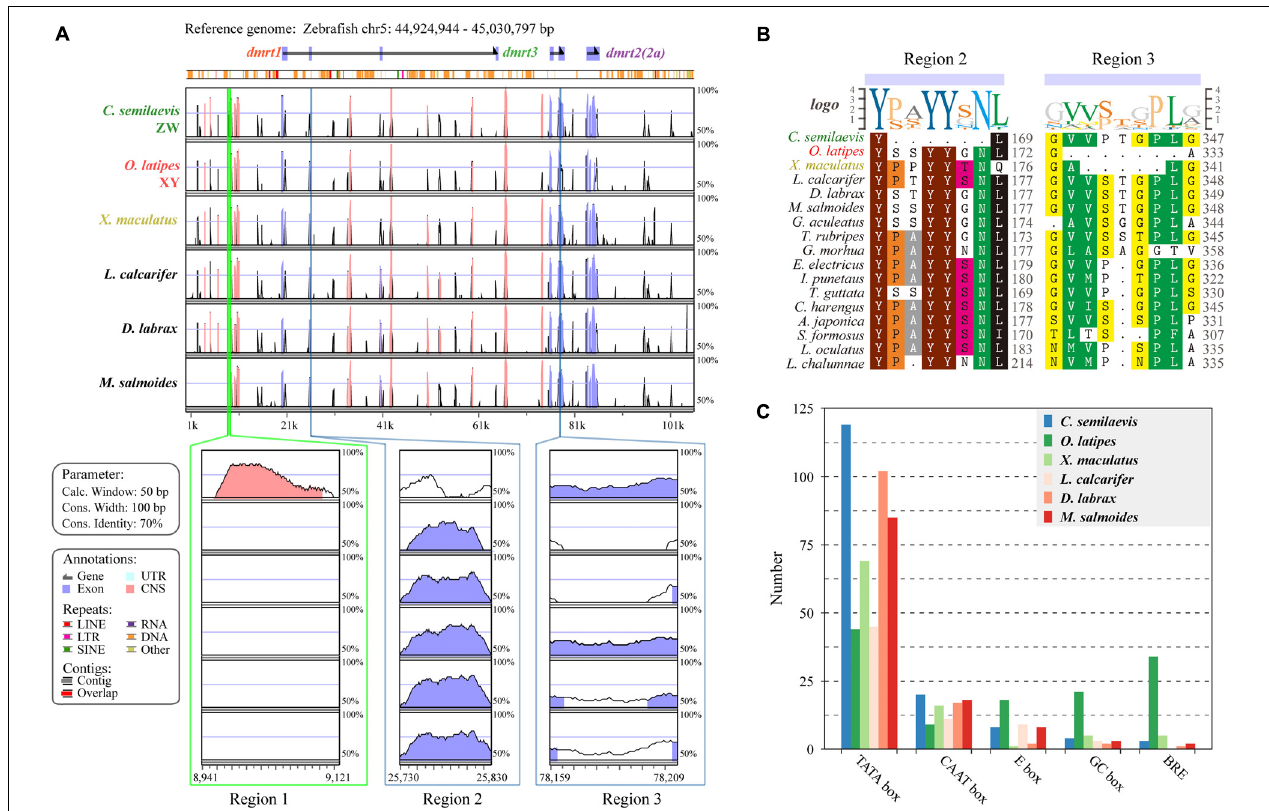
FIGURE 4 | Species variances of the regulatory regions in the dmrt1 - dmrt3 - dmrt2(2a) gene cluster. (A) A VISTA plot of the dmrt1 - dmrt3 - dmrt2(2a) gene clusters among six examined fish species. Peaks of similarity in pair-wise sequence alignments between zebrafish ( D. rerio ) are compared with Chinese tongue sole ( C. semilaevis ), Japanese medaka ( O. latipes ), southern platyfish ( X. maculatus ), Asian sea bass ( L. calcarifer ), European sea bass ( D. labrax ), and largemouth bass ( M. salmoides ). Blue peaks represent coding exons and pink peaks denote non-coding sequences. The horizontal axis shows relative positions in the zebrafish genomic sequence, whereas the vertical axis indicates percentage of identity (50–100%). Three distinct regions, named as Region 1, Region 2, and Region 3, were identified. (B) Protein sequence alignments of the Regions 2 and 3 in 17 examined fish species. (C) Numbers of different regulatory elements in six representative fish species. Additional details regarding the sequences of each regulatory element are provided in Supplementary Table S4